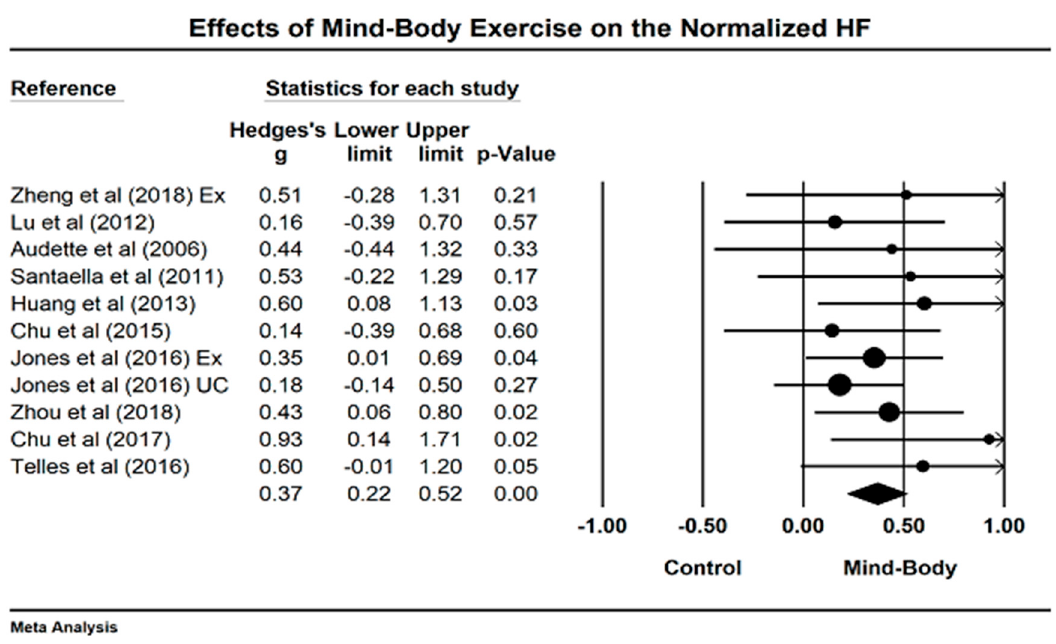
Figure 4. Effects of mind–body exercise on the normalized high-frequency power.